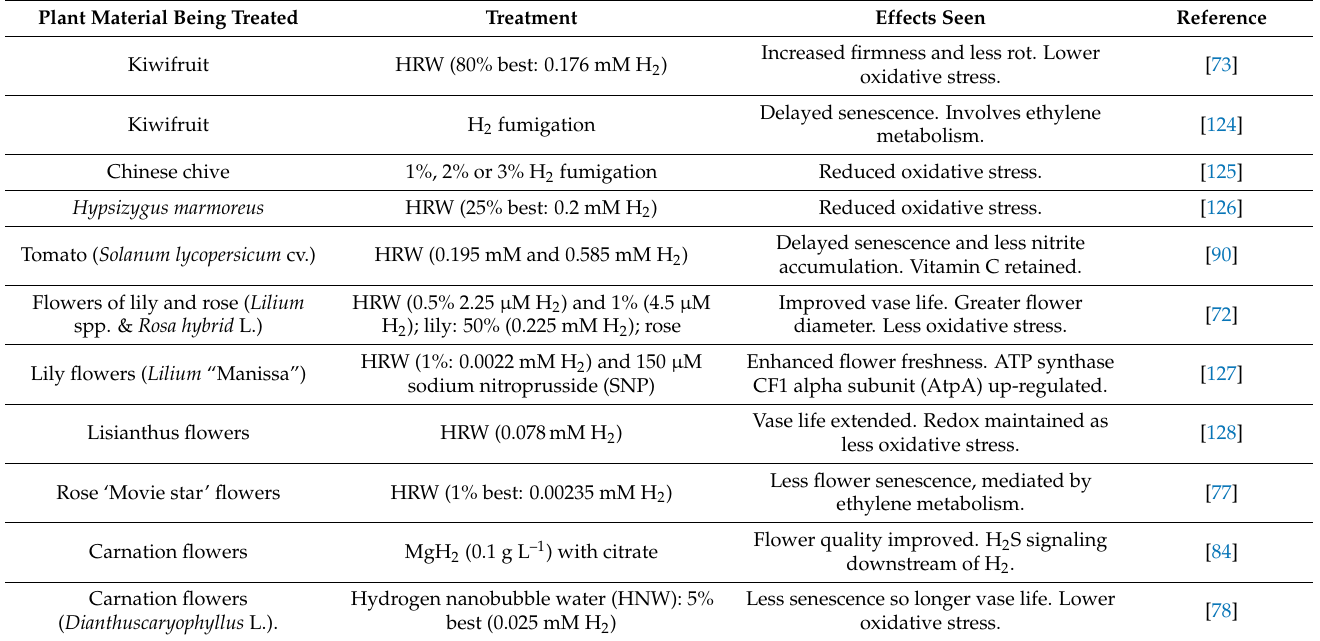
Table 3. Examples of the use of H 2 treatments for postharvest of plant materials. Flowers are all cut. H 2 concentrations are calculated from information given in relevant